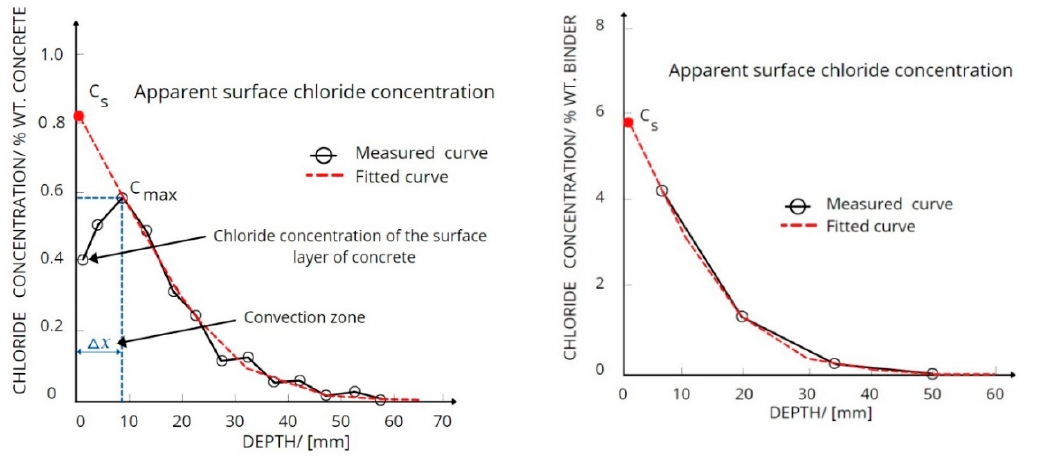
Figure 2. Schematic diagrams for determining C s under different conditions.